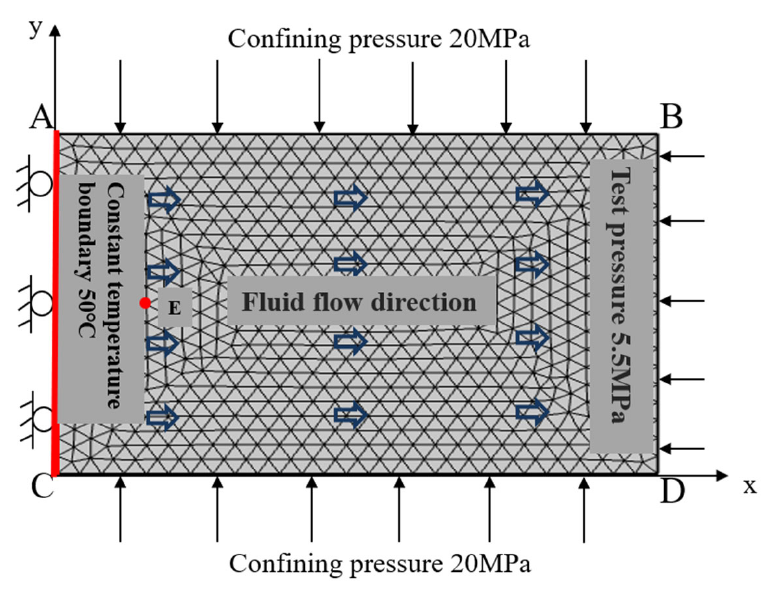
Figure 6. Computational model for the control experiment. Table 3. The model parameters in the calculations for a gas production process.